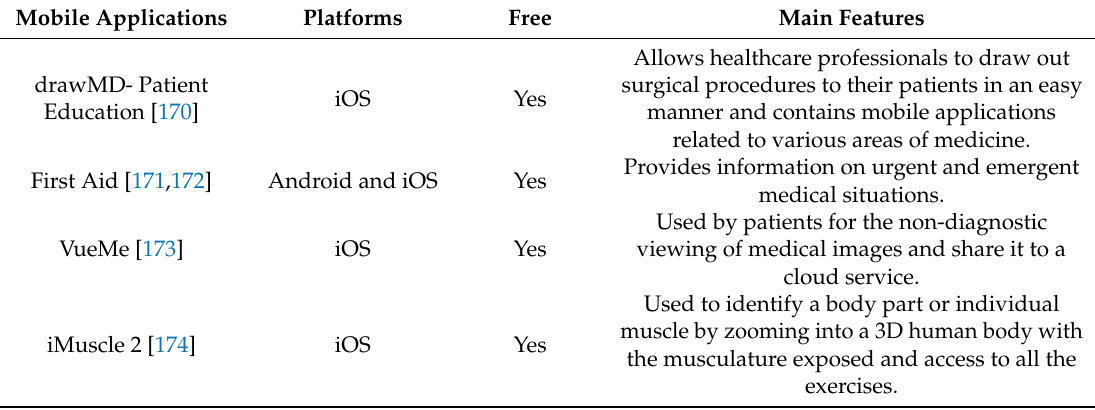
Table 7. Mobile health applications related to educational applications for